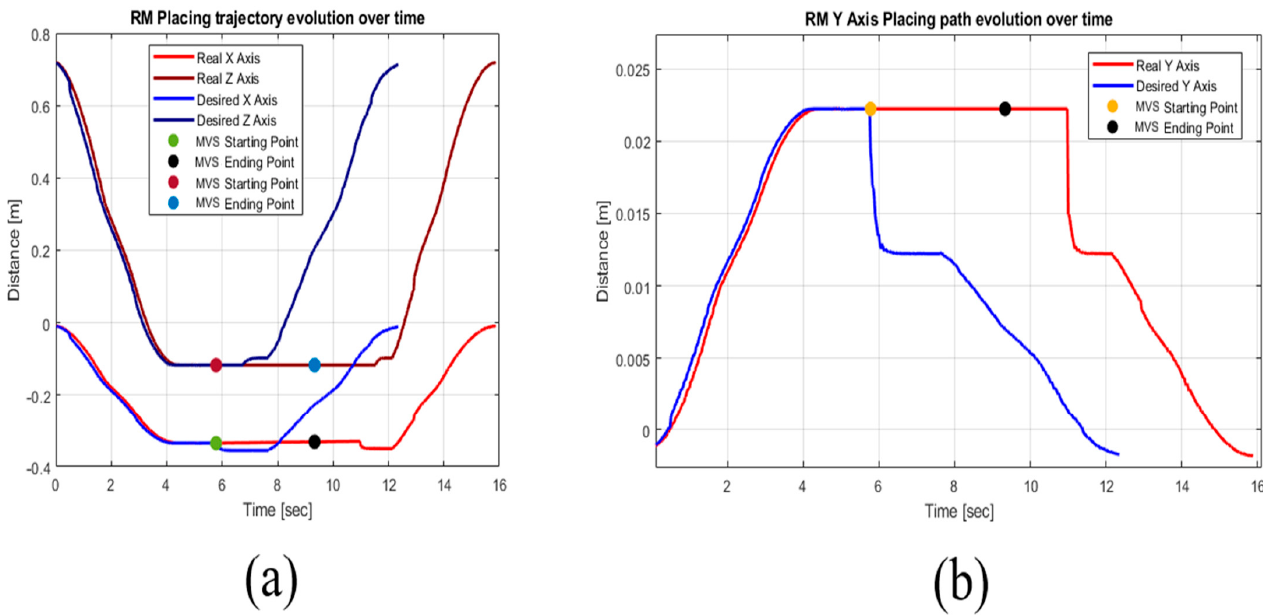
Figure 18. Trajectories evolution over time for ( a ) X and Z axis and ( b ) Y axis in the case of picking the workpiece.